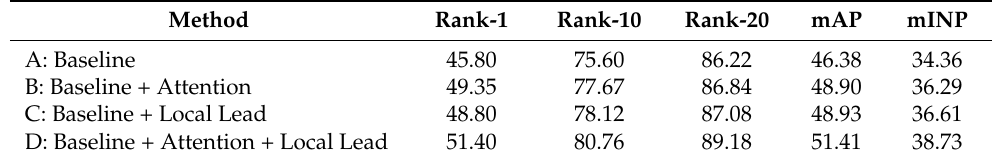
Table 5. Ablation